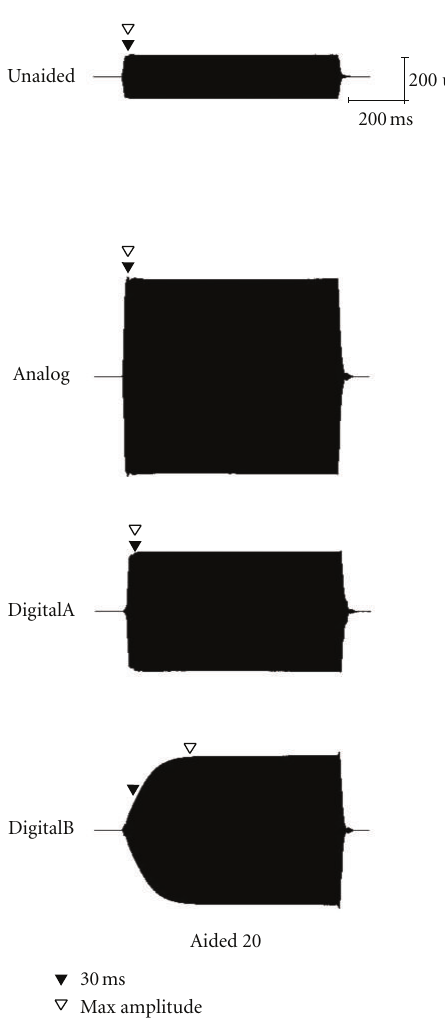
Figure 6: Waveform of the long stimulus presented at 70dB SPL as measured in the ear canal of a single representative subject (subject